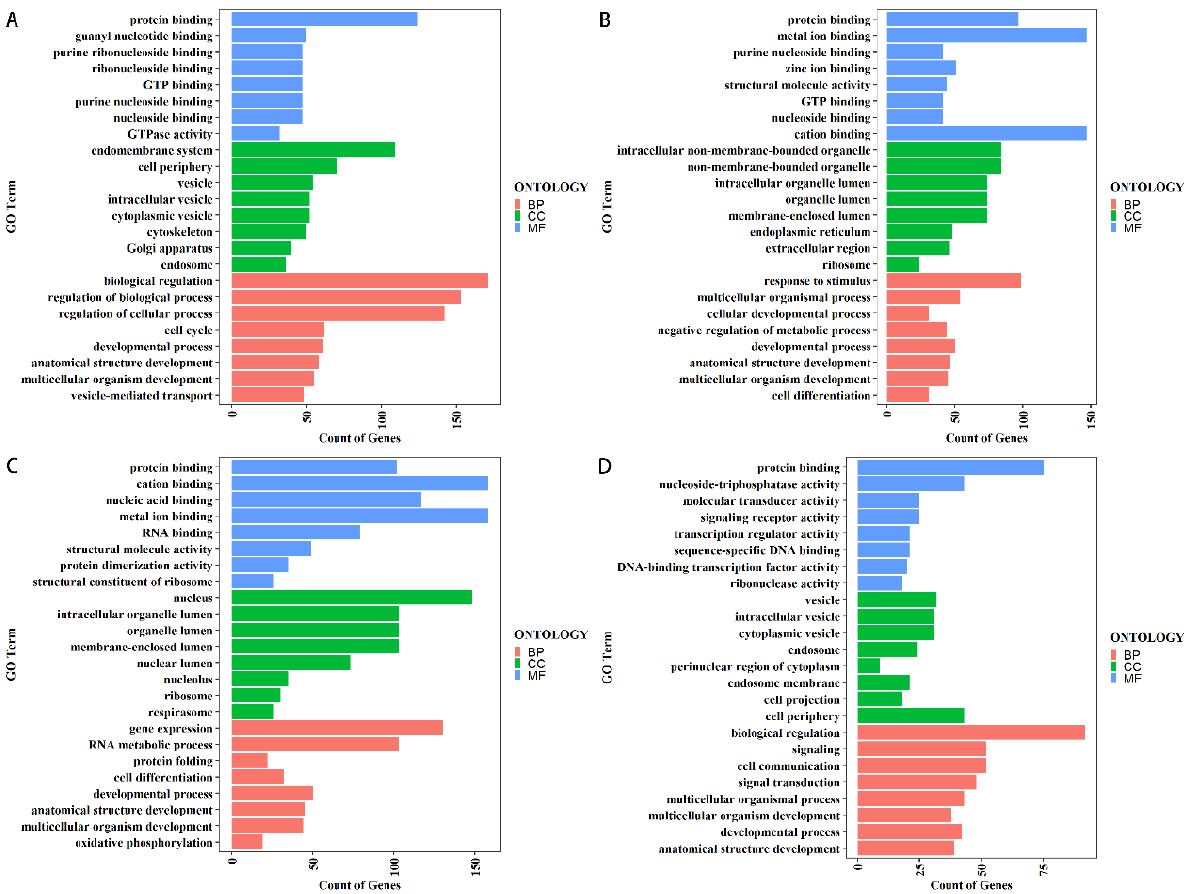
Figure 3. GO analysis of DEGs in differentially resistant strains following inoculation. These genes were divided into three groups based on cellular components. Biological process (BP), cellular component (CC), and molecular function (MF). ( A ) Upregulated DEGs in p50+ vs. p50 − group, ( B ) upregulated DEGs in C108+ vs. C108 − group, ( C ) downregulated DEGs in p50+ vs. p50 − group, ( D ) downregulated DEGs in C108+ vs. C108 − group.